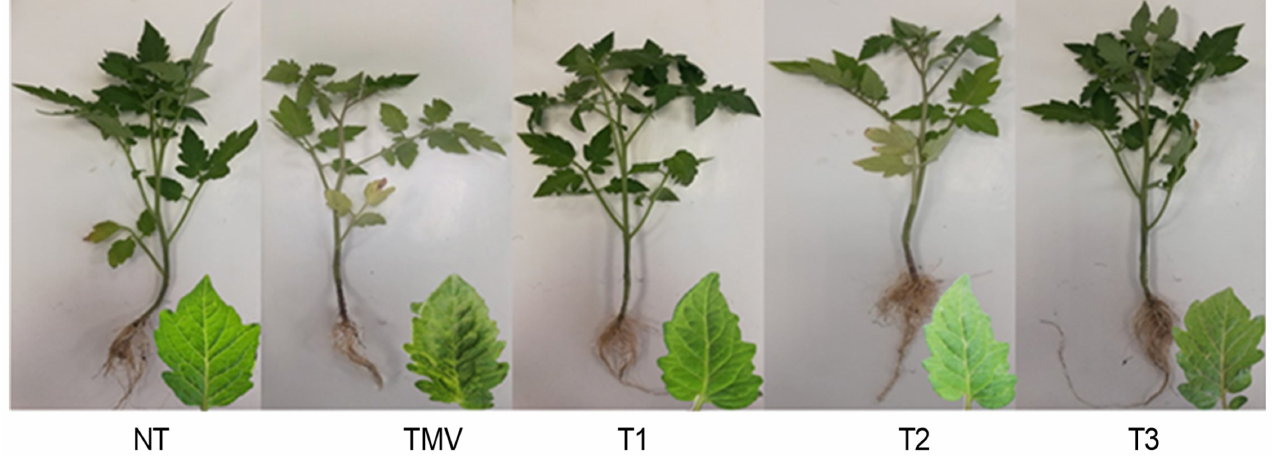
Figure 2. Effect of foliar application of B. subtilis strain HA1-CF on the development of disease symptoms in tomato leaves at 14 days post-TMV inoculation. NT: mock plants; TMV: virus-infected plants; T1: tomato plants sprayed with bacterial culture filtrate 24 h before virus infection; T2: tomato plants sprayed with bacterial culture filtrate 24 h after virus infection; T3: tomato plants sprayed with bacterial culture filtrate two times, 24 h before and 24 h after virus